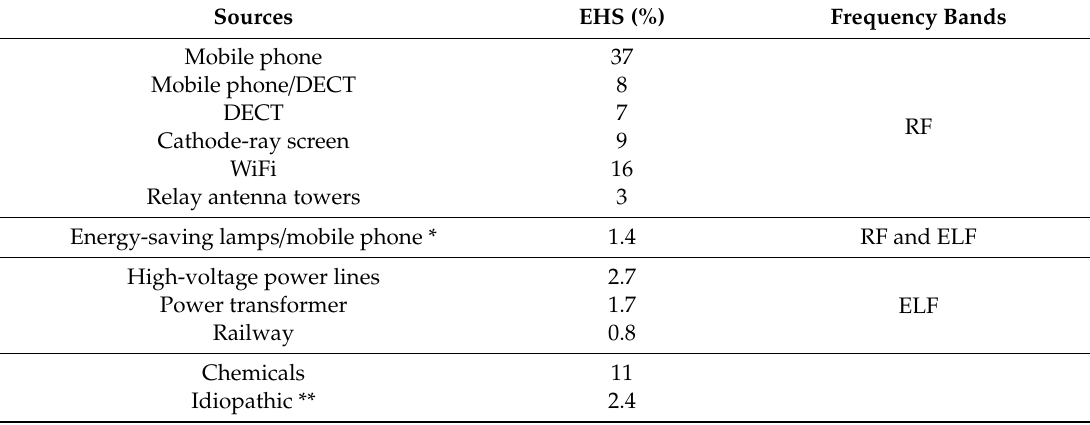
Table 8. Clinical analysis of self-reported excessive presumed EMF and chemical exposure preceding the occurrence of electrohypersensibility (unpublished data). DECT—digital enhanced cordless telecommunications; RF—radiofrequency; ELF—extremely low frequency. Sources EHS (%) Frequency Bands Mobile phone